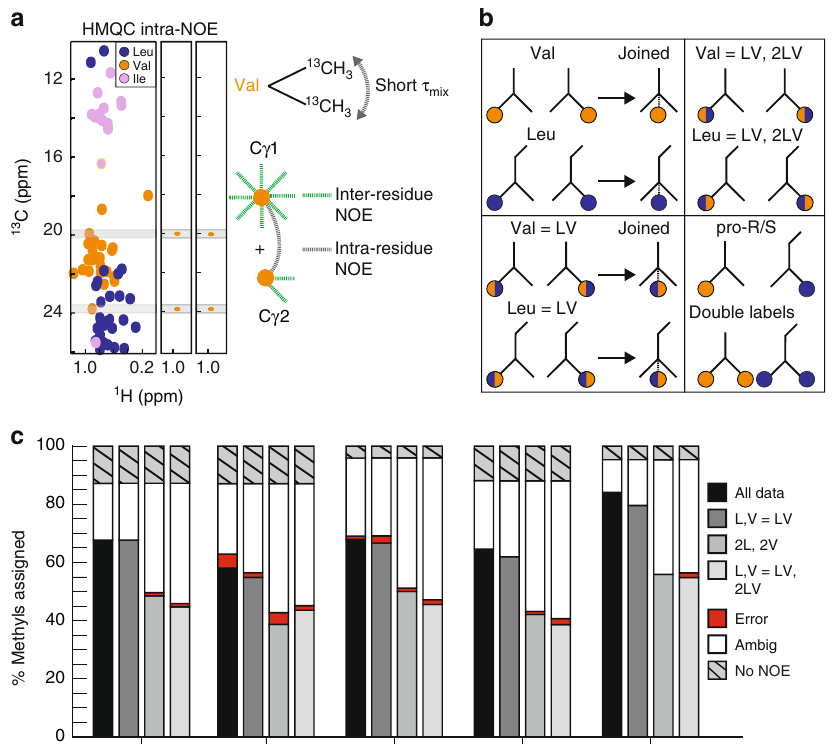
Fig. 3 MethylFLYA performance with reduced data input. a Geminal methyl groups of Leu/Val residues can be linked with a short-mixing time NOESY experiment on an exclusively double methyl-labeled ([ 13 δ 1 / 13 δ 2 ]-Leu, [ 13 γ 1 / 13 γ 2 ]-Val) protein sample. In the NOESY plane of each Leu/Val methyl resonance, a strong signal from its geminal methyl resonance is observed (right). b Different possibilities for treating Leu/Val methyl resonances in MethylFLYA. Top, left: differentiation of the Leu- and Val-type of methyl resonances and known connectivity between geminal Leu or Val methyl groups. Bottom, left: no differentiation between methyl resonances of the Leu- or Val-type, but known connectivity between geminal methyl groups. Top, right: no differentiation between methyl resonances of the Leu/Val-type, nor knowledge of the geminal methyl connectivity. Bottom, right: stereospeci fi c labelling of Leu/Val-methyl groups (pro-R or pro-S), or double labelling (both pro-R and pro-S). c MethylFLYA results with reduced data input. The percentage of assigned methyl groups given knowledge of all methyl amino acid types and the geminal Leu/Val-methyl connectivity is shown in black (all data). In dark gray (L, V = LV), knowledge of Ile- and Ala-methyl resonance types is assumed, but there is no discrimination between Leu or Val methyl resonance types. The geminal (Leu/Val) methyl resonances are connected. In light gray (2L, 2V), knowledge of all amino-acid types is assumed, but the geminal pairing of Leu/Val resonances is omitted. In silver (L, V = LV, 2LV), neither the amino-acid type nor the geminal pairing is known for Leu/Val methyl